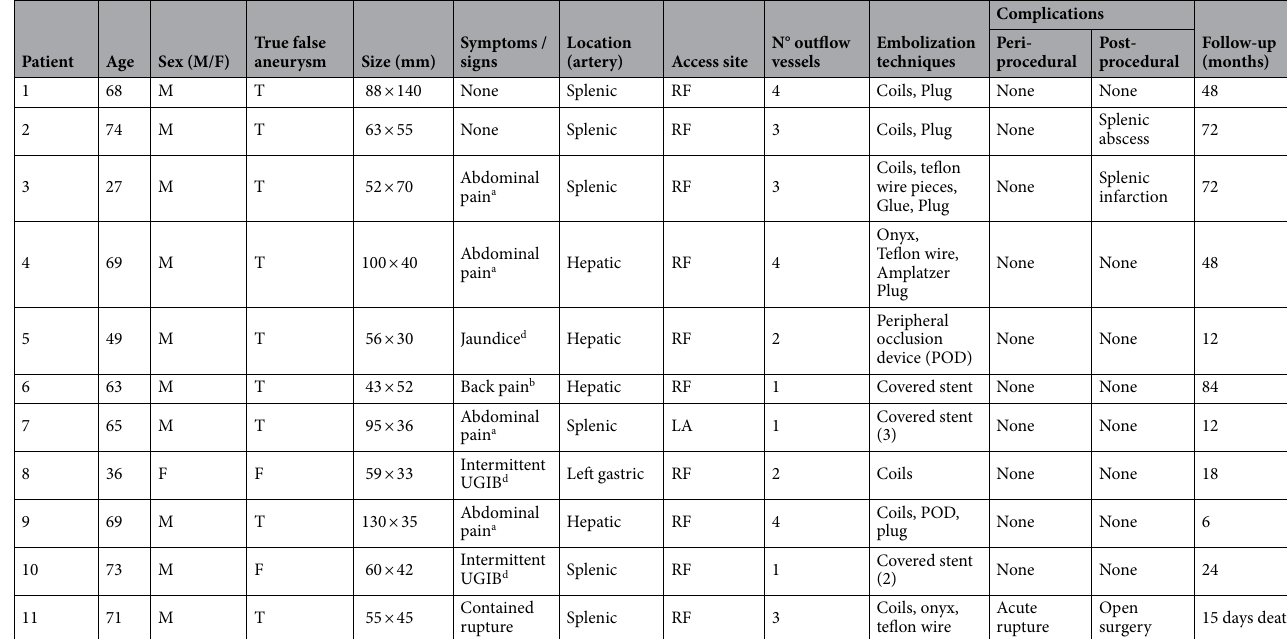
Table 1. Patient’s characteristics. M: male, F: Female, T: true, F: False, RF: right femoral, LA: left axillary. a Abdominal pain: patients presented with abdominal discomfort and pain, probably due to the large dimension of the aneurysm. After the endovascular embolization, a relieve of the pain was obtained in all patients. b Back lumbar Pain: probably due to the compression of the celiac plexus. When patients presented with pain it was referred to the aneurysm after excluding other possible causes. c Jaundice: due to the extrinsic compression of the main biliary duct with dilatation of the intrahepatic ducts. The patient was treated with a percutaneous biliary drainage and, subsequently, with an endovascular embolization obtaining a rapid decompression because of an aneurysm shrunk. d Intermittent Upper Gastrointestinal Bleeding – UGIB: both patients had pseudo-aneurysmatic lesions presenting with moderate anemia resulting from slow bleeding arising from the gastric wall in contact with the pseudoaneurysm. The lesions were detected at the CTA, requested after endoscopic